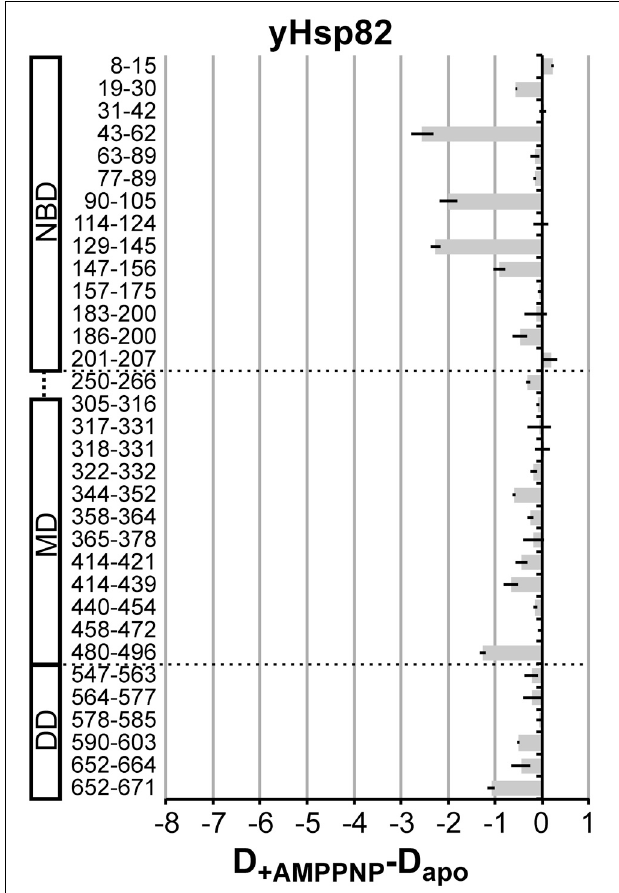
FIGURE 5 | AMPPNP-induced changes in the HX kinetics in yHsp82. Difference plots of deuterons incorporated in the presence of AMPPNP minus deuterons incorporated in the absence of nucleotides into yHsp82 after 30s in D 2 O. The numbers to the left indicate the corresponding peptic peptide. Presented are the means of three independent experiments. Domain structure of yHsp90 is shown left of the graph. Dashed lines indicate domain boundaries.